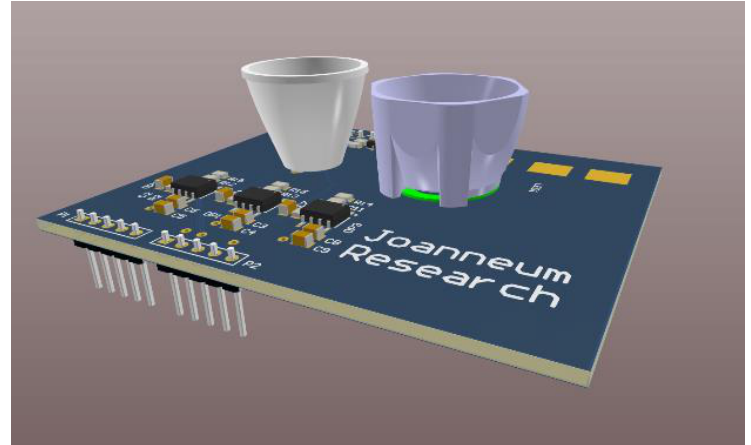
Figure 1. 3D model of the VLS unit.